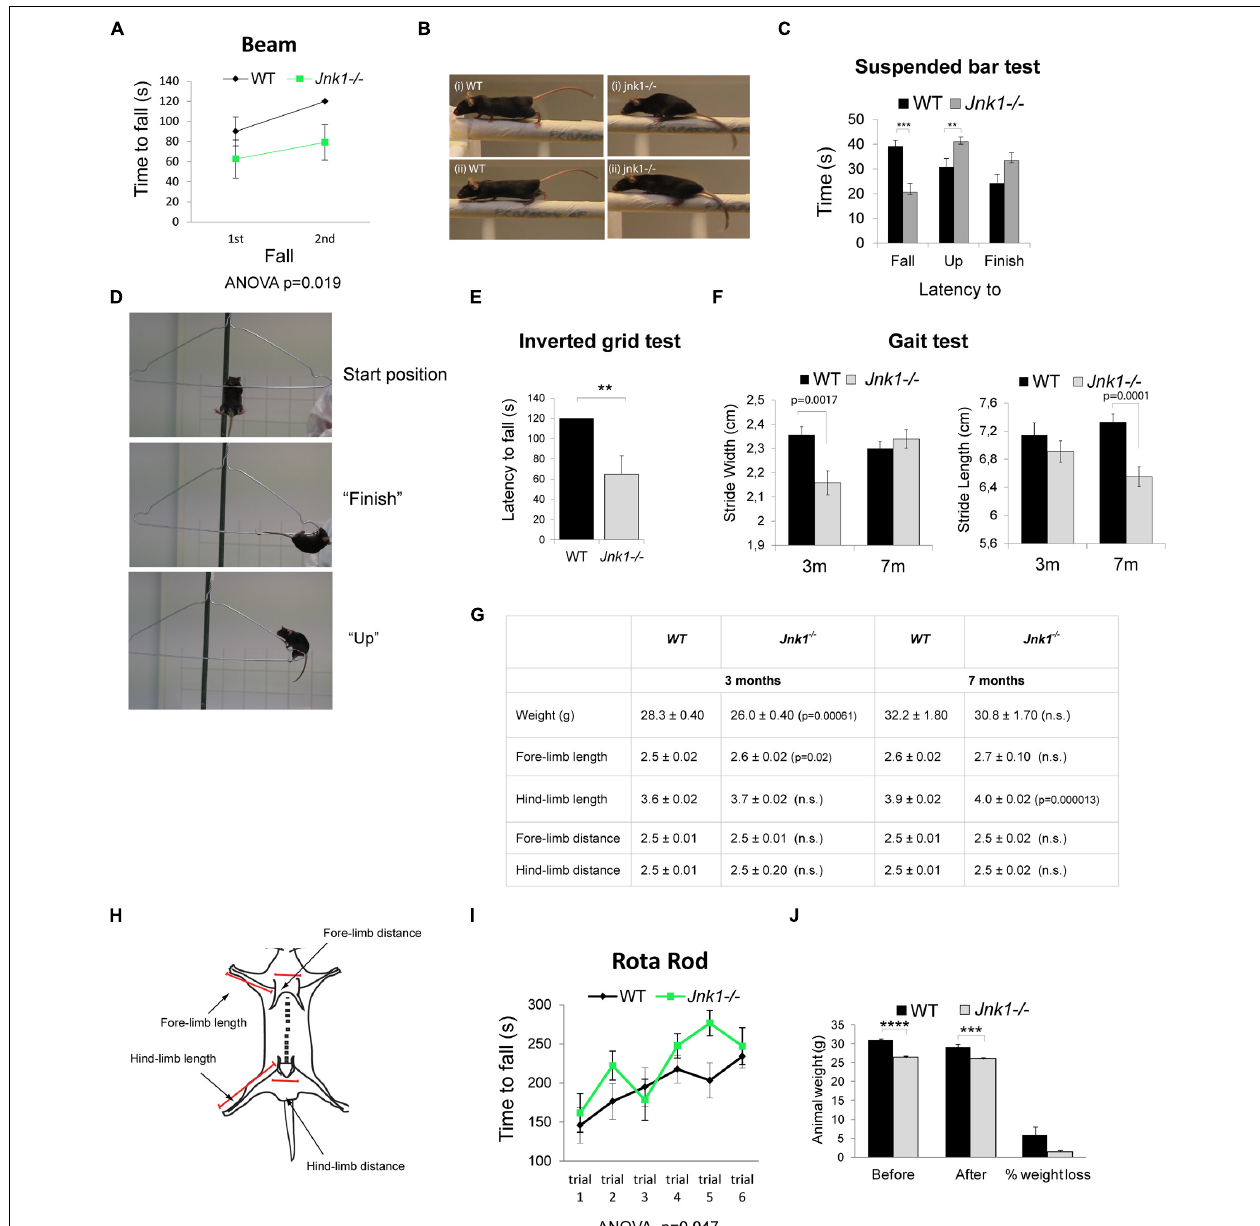
7 month (7 m) mice. Jnk1-/- mice at 3 m displayed a significantly narrower stride width thanWT mice. By 7 m the difference in stride width was no longer significant however stride length was significantly reduced in Jnk1-/- mice.Twelve mice from each genotype were analyzed. (G) A table displaying the anatomical measurements ofWT and Jnk1-/- mice at 3 m and 7 m is shown. Meaned data ± SEM from 11WT and 12 Jnk1-/- mice at 3 m and from fiveWT and seven Jnk1-/- mice at 7 m, are shown.Where significant difference toWT exists, p- values are indicated. N.s. indicates that differences compared to controls were not significant. (H) The scheme illustrates the measurement strategy used to determine length of forelimbs and hindlimbs. (I) Mice were subjected to the accelerating rotarod test.There was no phenotypic difference between genotypes. Data shown are meaned from eightWT and eight Jnk1-/- male mice. (J) The average weight of 8-week old WT and Jnk1-/- mice before and after the battery of behavioral tests is shown. Jnk1-/- mice were significantly lighter thanWT. For all graphs, means ± SEMs are shown. Levels of significance determined by ANOVA or Student’s t -test, are as follows: ** p < 0.01; *** p < 0.001; **** p <